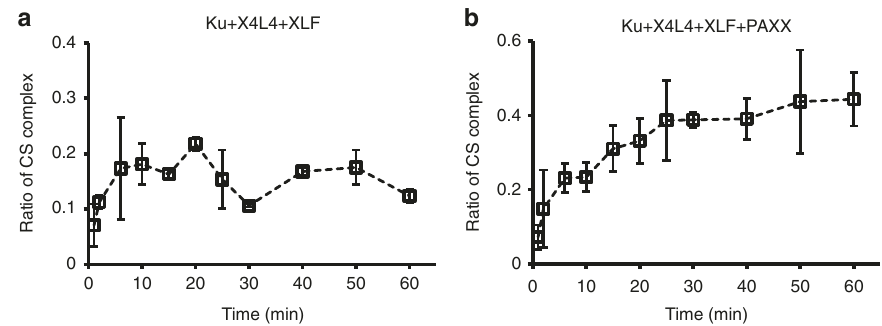
Fig. 5 Time-dependent accumulation of CS complex. a , b Kinetics of CS complex formation with 25 nM Ku, 50 nM X4L4, and 50 nM XLF ( a ) or with 25 nM Ku, 50 nM X4L4, 50 nM XLF, and 50 nM PAXX ( b ). Data are represented as the mean ± SD of two independent replicates. Source data are provided as